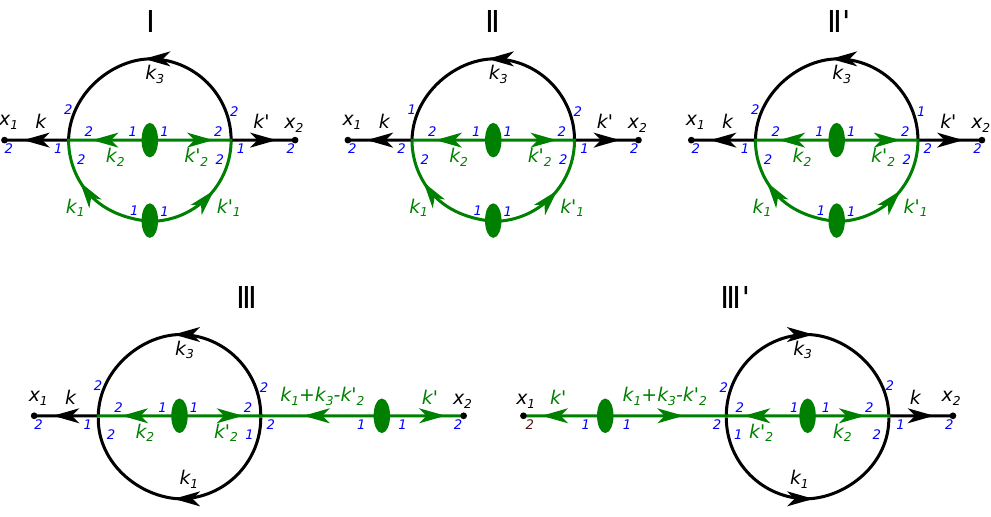
Figure 3 . The diagrams for the 2 ! 2 rescattering correction to the classical (cid:12)eld Green function that we calculate in this section. The green oval, along with the attached propagators, denote the classical correlation